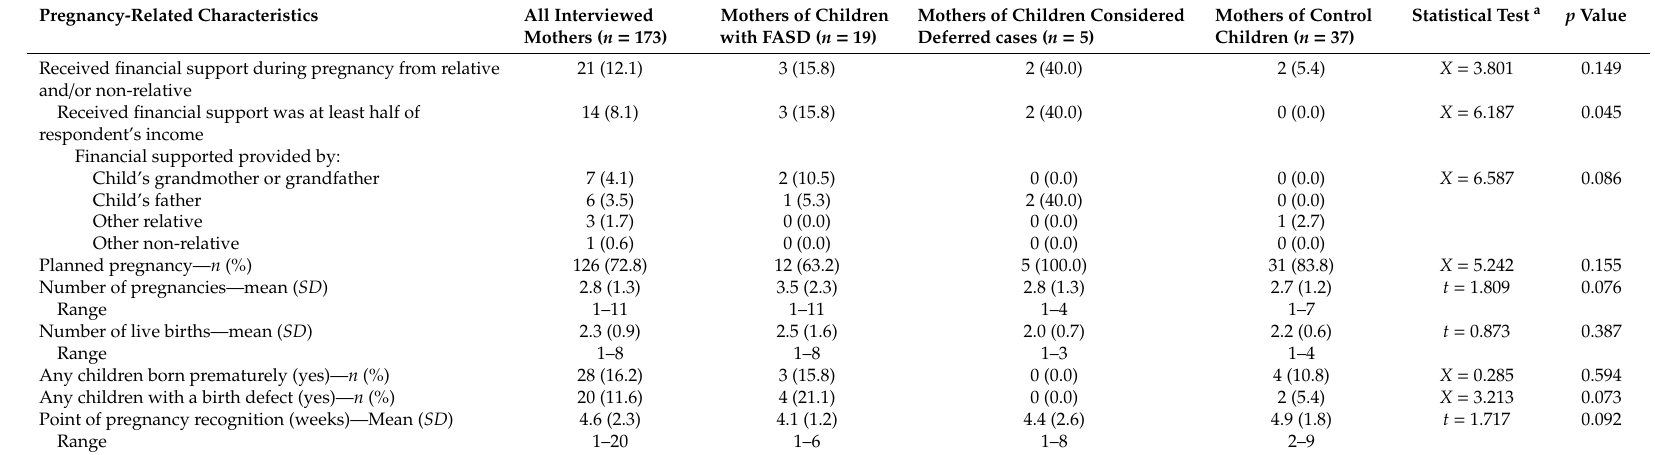
Table 3. Pregnancy-related characteristics among all interviewed mothers, mothers of children with FASD and mothers of control children. Pregnancy-Related